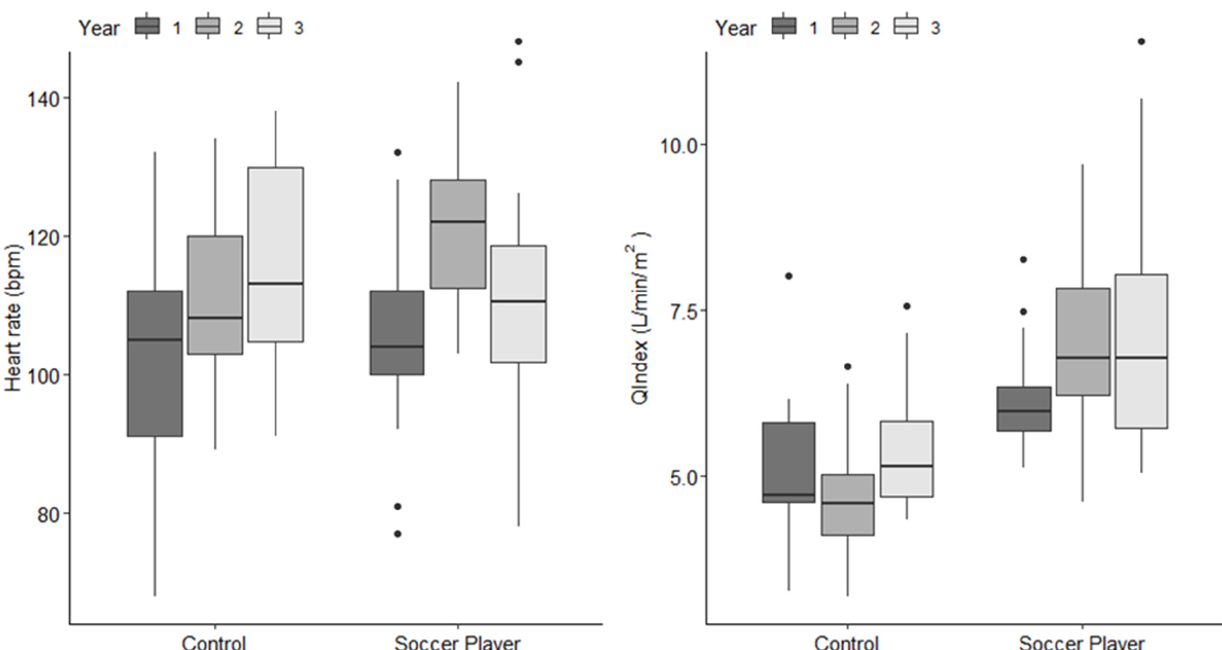
. VO 2 peak in the control